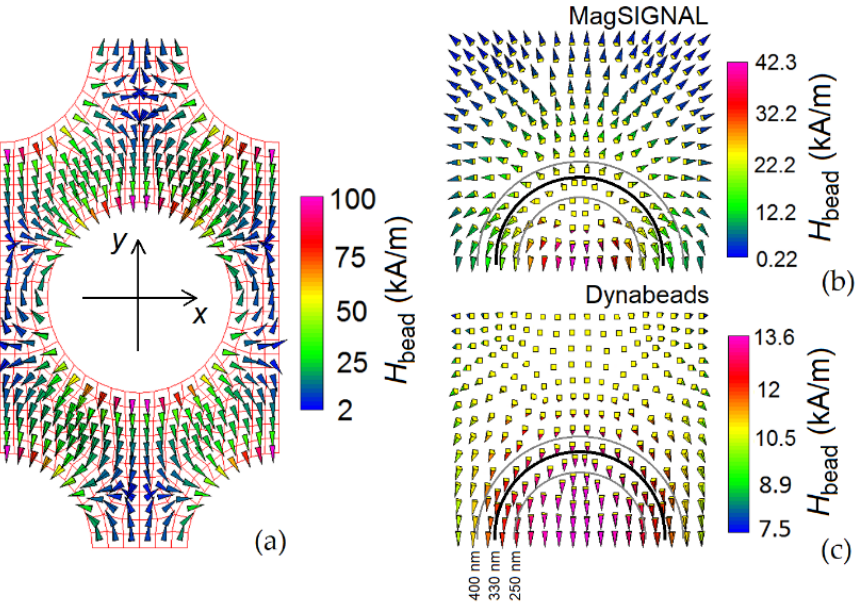
Figure 5. ( a ) Spatial distribution of the demagnetizing field in the unit cell of the permalloy nanostruc- tured film with 330 nm holes. Spatial distribution of the stray field produced on the film surface by ( b ) MagSIGNAL-STA and ( c ) Dynabeads MyOne beads, centered with the film holes and in contact with the film surface.